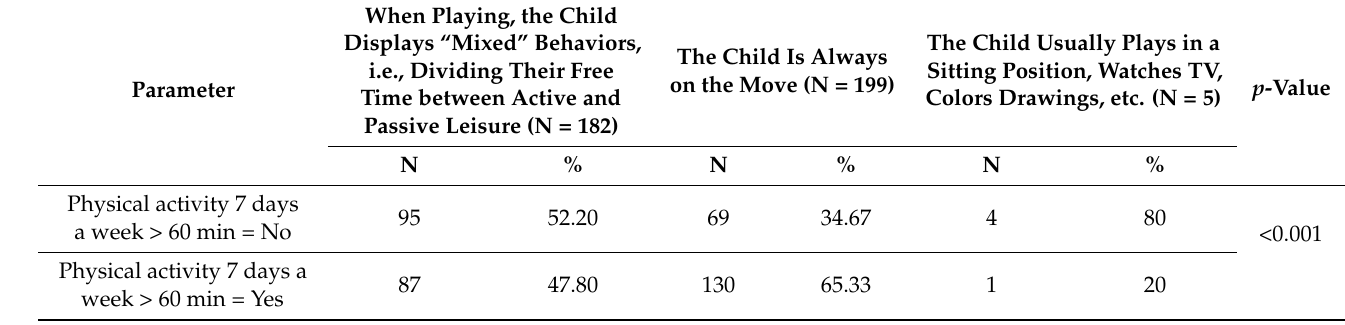
Table 5. The relationship between the type of time spent at home and taking up sufficient physical